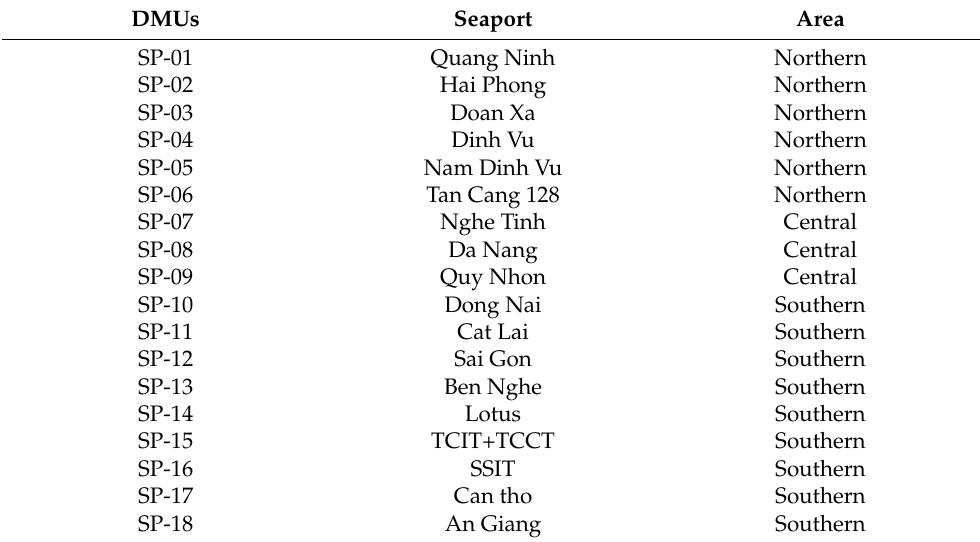
Table 2. List of